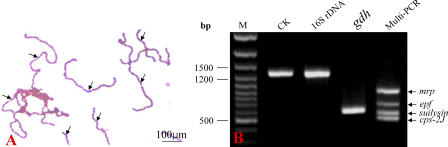
Detection of the Pathogenic SS2 and Identification of Its Specific Genes(A) Light microscopy image of the isolates cultured from autopsy specimens.GP
+ cocci (pointed to with black arrows) are arranged in various short chains (×100).
(B) Qualitative PCR detection of isolates from the liver of fatal human cases with a set of primers specific for
S.
suis 2. M: 100bp DNA marker (Fermentas, Vilnius, Lithuania). CK: 16S rDNA PCR product from the R 735 standard strain of
S. suis 2. Multi-PCR: performed with a set of unique primers specific for
mrp, epf, suilysin, and
cps-2J, respectively.